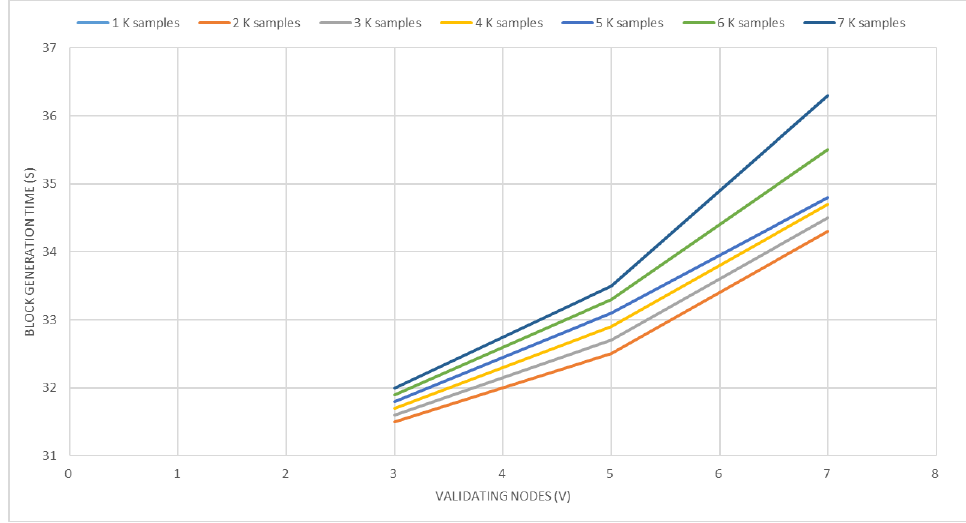
Figure 10. Block generation time for different